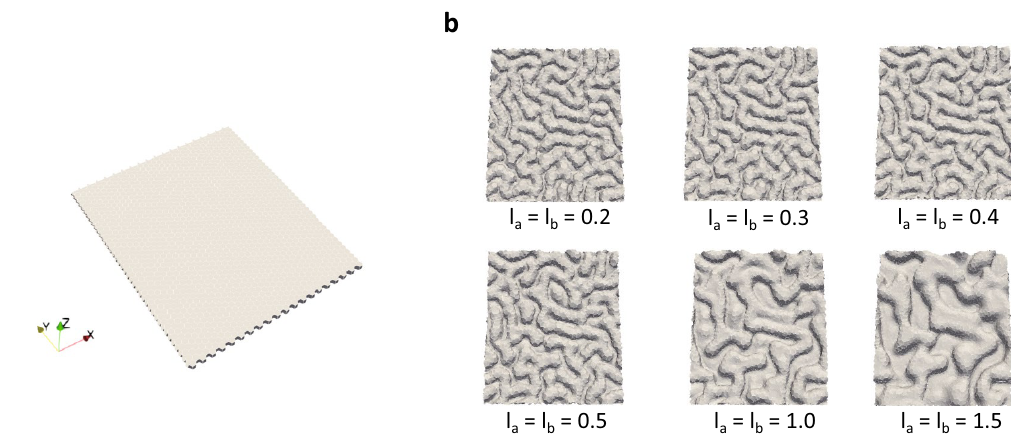
Figure 2. The initial condition and the results of the epithelial folding simulations. ( a ) Monolayer sheet as the initial condition. ( b ) Snapshots of epithelial folding simulated under the conditions of = l = 0.2, 0.3, 0.4, 0.5, 1.0, 1.5 . All snapshots show the simulation results at time t = 0.5 τ cycle l a b distance between the epithelial sheet and the elastic wall, the smaller the peak-to-peak distance of